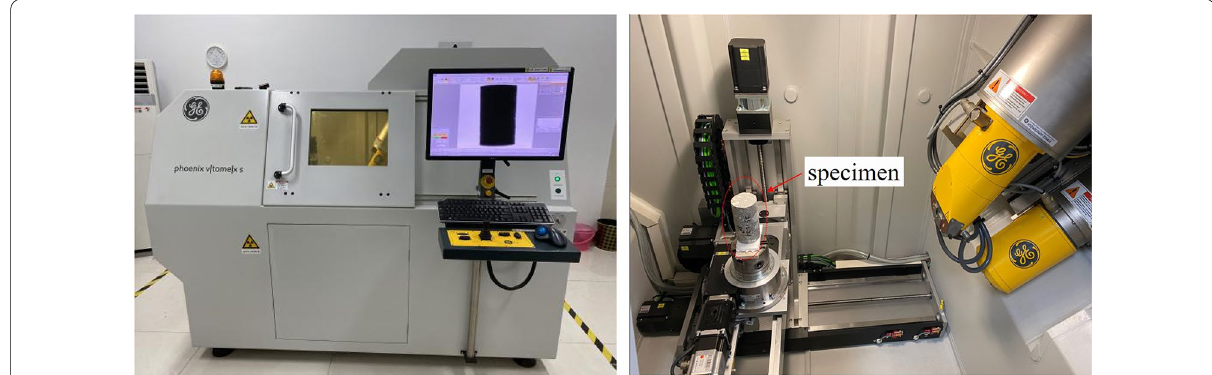
Fig. 3 X-CT scanning